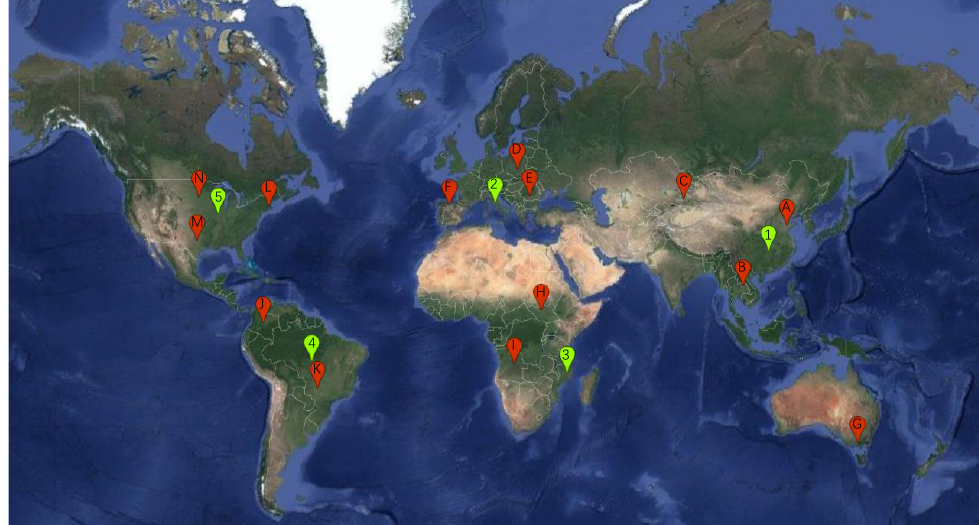
Figure 3. The distribution of training data and validation data (red represents the training set, and green represents the validation